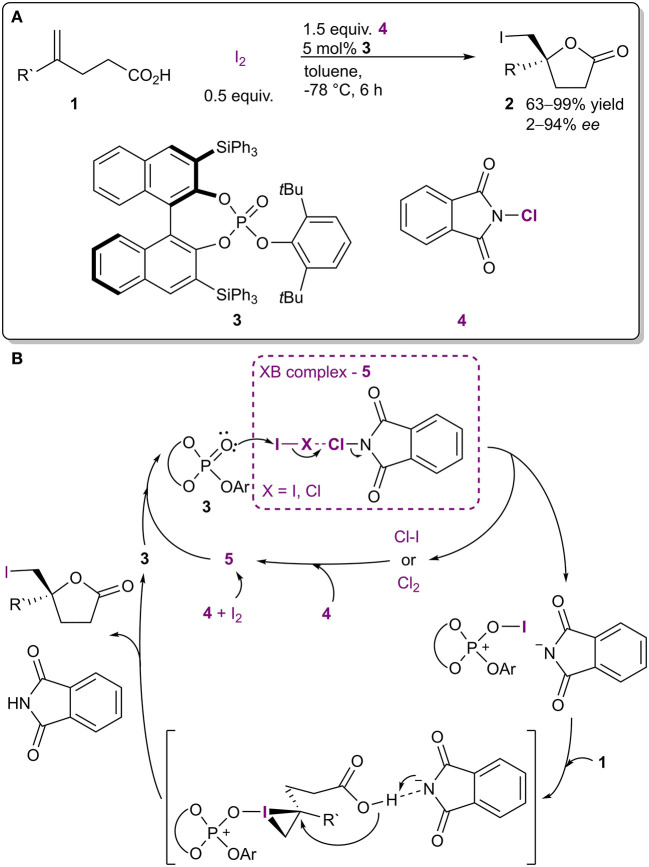
(A) Lewis base-catalyzed halocyclization utilizing the complex 5 as a halogenating agent; (B) proposed mechanism of the reaction.